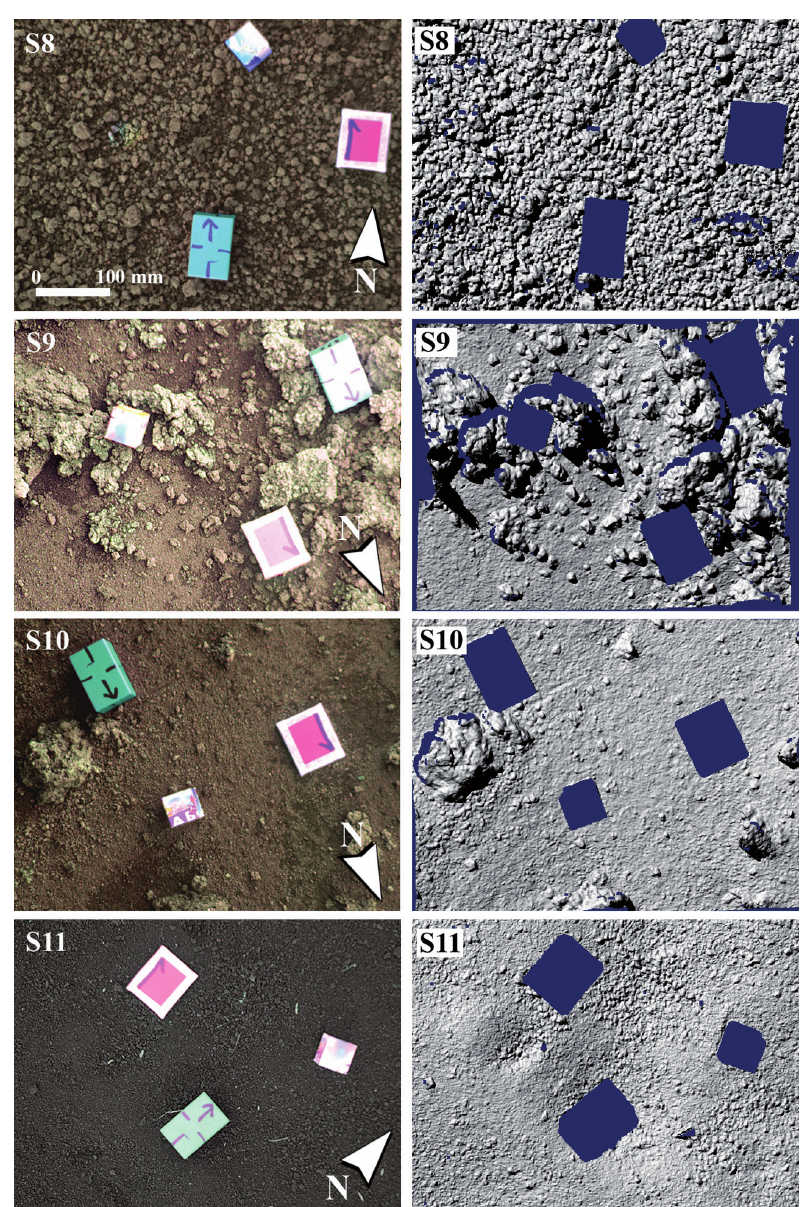
Fig. 3. Left column: RGB 24 bit colour images of the sampled surfaces acquired during 3D Laser scansion by a CCD camera. Right column: Shaded images (illumination from the top) of the digital elevation models of sampled surfaces. Scale bar shown on the top left corner image, is the same for all images. Coloured boxes and panels on figures (blue areas on shaded images) are reference features used to construct DEM of surfaces. The white arrows show